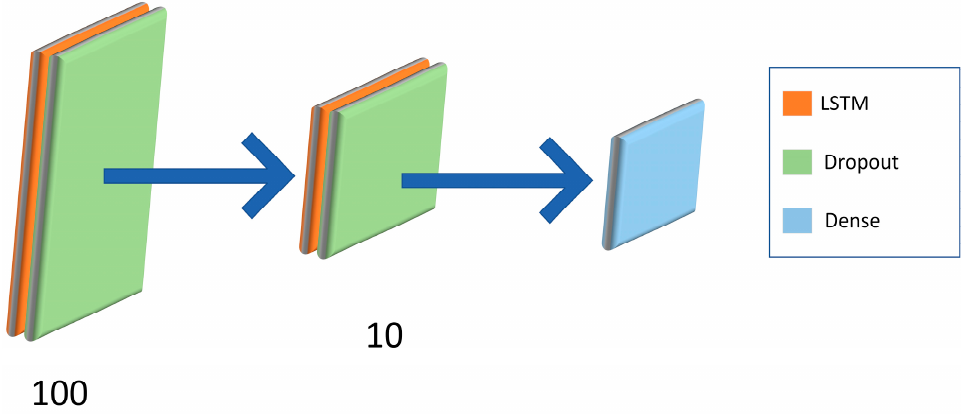
Figure 17. LSTM model fuser. Table 3. LSTM parameter setting.